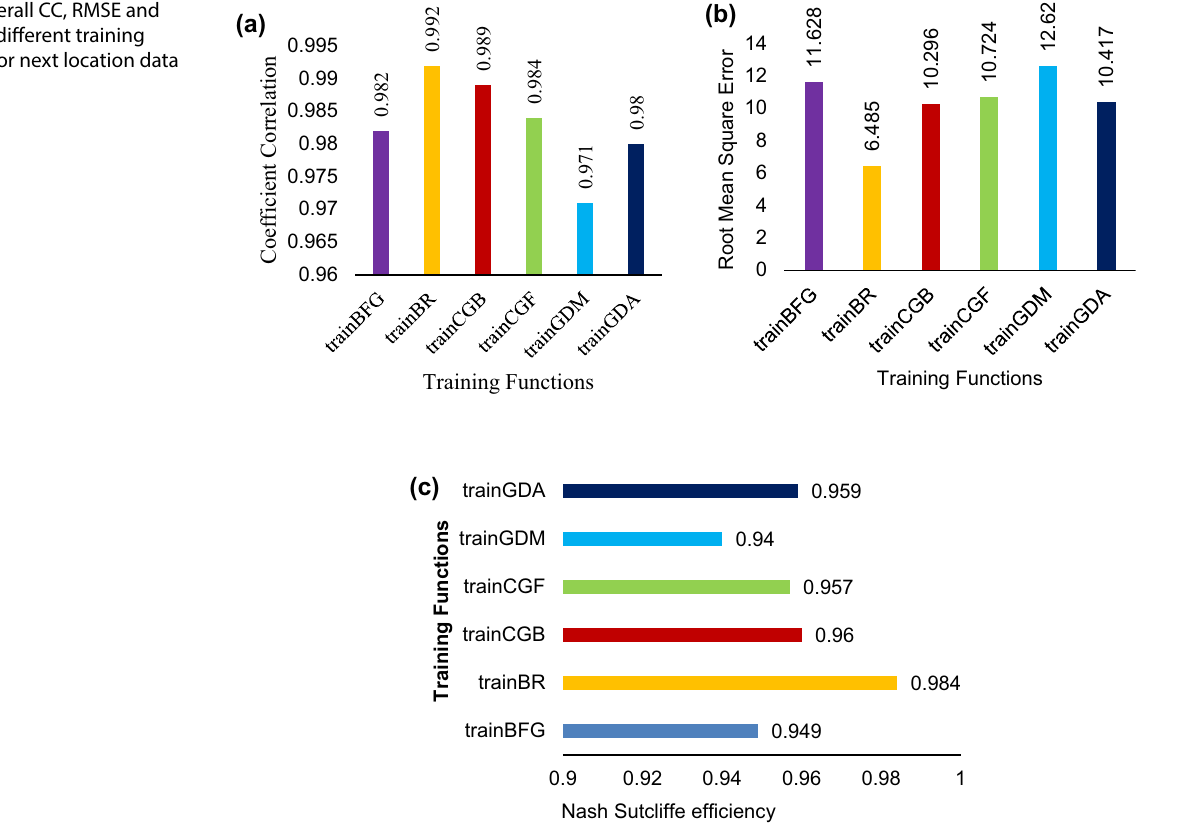
Fig. 11 Overall CC, RMSE and NSE using different training functions for next location data prediction